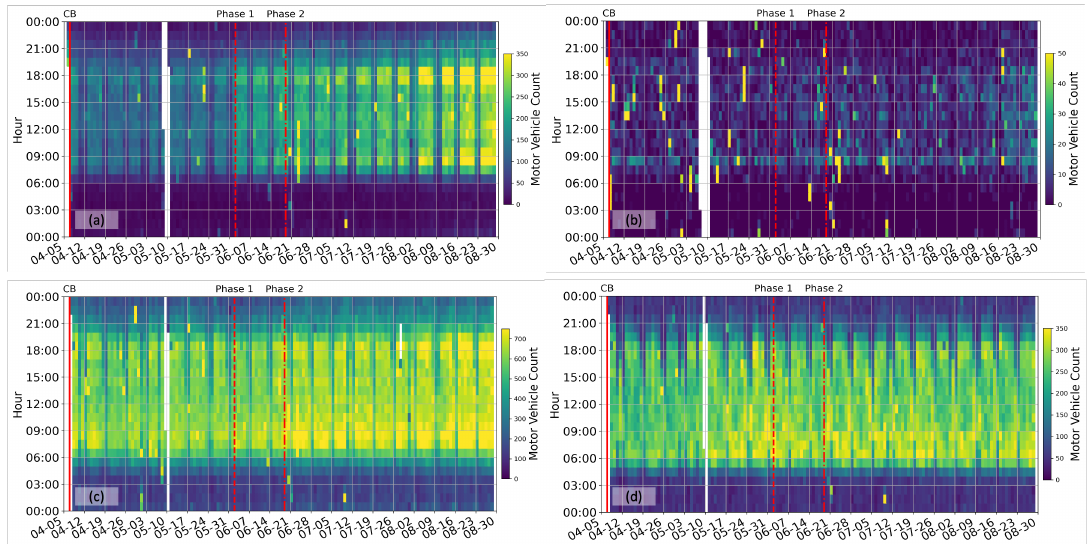
Figure 6. Motor vehicle count extracted from high-frequency ambient seismic data at ( a ) NUS hilltop, ( b ) NUS exit, ( c ) West Coast Highway, and ( d ) West Coast Park, respectively. The legends are the same as Figure